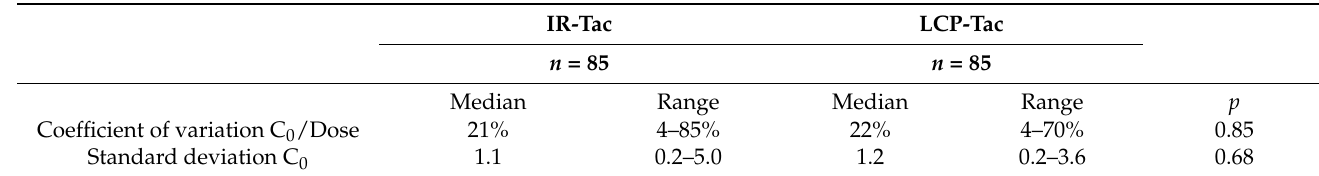
Table 3. Effect of conversion to LCP-Tac on intra-patient variability of tacrolimus levels, n = 85.